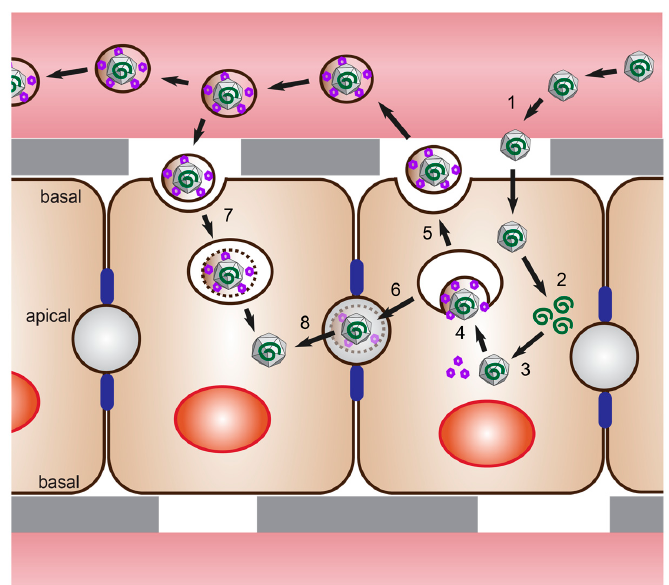
Figure 1. Hepatitis E virus (HEV) life cycle and transmission. (1) Supposedly naked HEV (nHEV) particles reach the liver and infect hepatocytes through their basolateral membrane. (2) Replication of the HEV genome (green) mediated by HEV nonstructural proteins occurs in a yet uncharacterized cellular compartment. (3) Translation of the subgenomic RNA leads to the translation of open reading frame 2 (ORF2) capsid protein (grey) and ORF3 protein (purple). The assembly site of infectious HEV particles is unknown. (4) Progeny HEV particles bud into multivesicular buddies mediated by the interaction of ORF3 with the ESCRT machinery of the host cell. (5) Basolaterally secreted HEV particles are quasi-enveloped (eHEV) and circulate in this form in the bloodstream. (6) Apically secreted particles supposedly bud as eHEV particles and are then matured into nHEV particles. While exact modes of nHEV entry (1) are unknown, (7) eHEV particles enter through clathrin-dependent endocytosis. Cell-to-cell transmission or (8) transmission between neighboring apical domains have not been described yet.